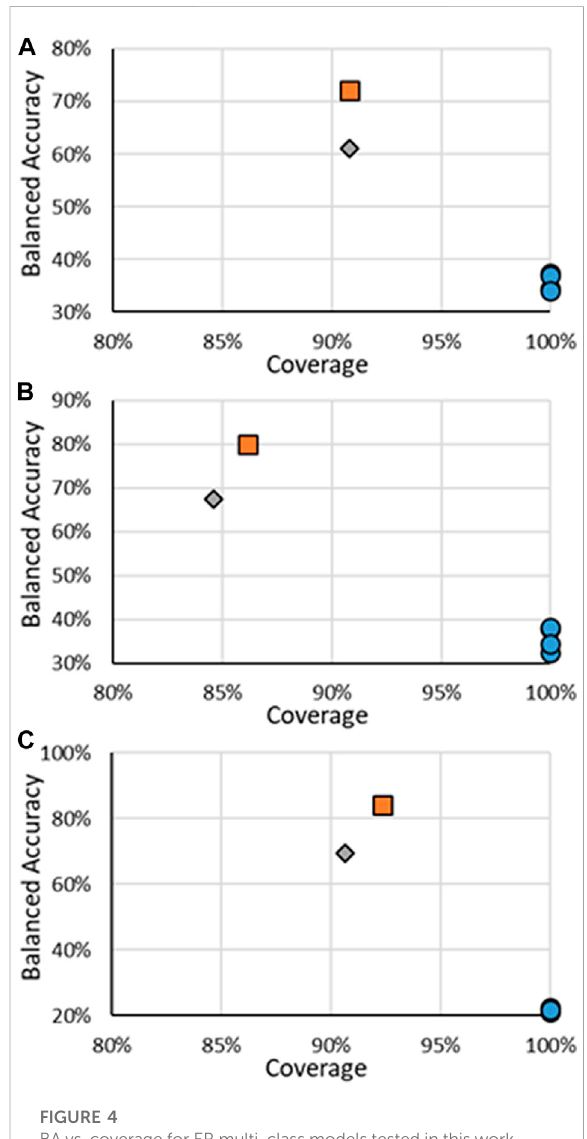
FIGURE 4 BA vs. coverage for ER multi-class models tested in this work for (A) binding, (B) agonism, and (C) antagonism. Orange squares are for RF models when all substances are considered, gray diamonds are when only the substances in the RF test substances are considered, and blue circles are for other